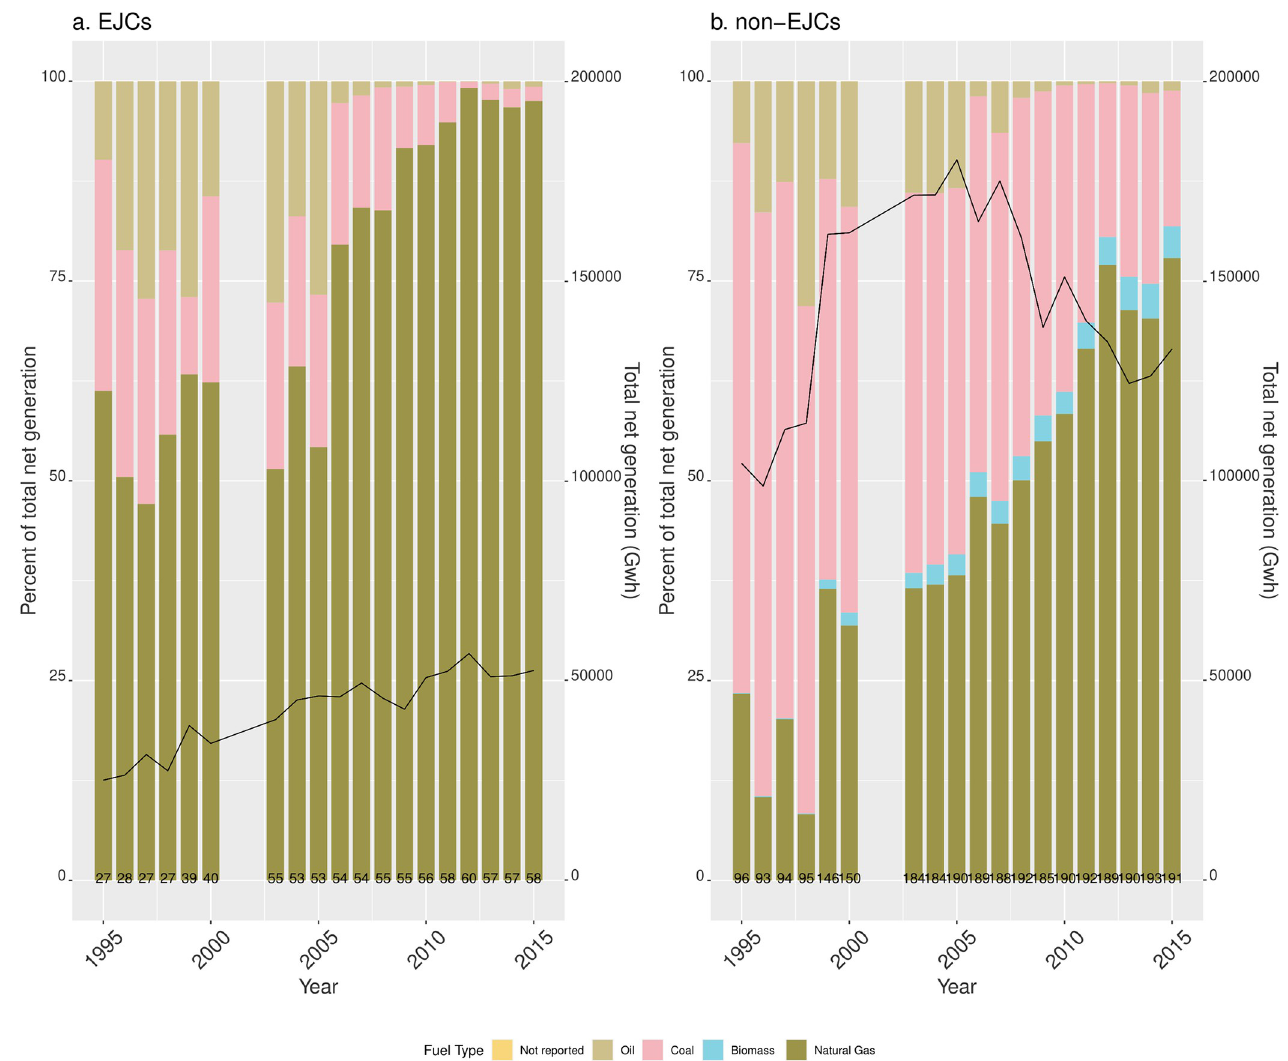
Fig 5. Total net generation by fuel type in EGUs in RGGI sited in (A) EJCs and (B) non-EJCs. Percent of total net generation by fuel type is indicated in left y- axis. Black lines indicate total generation and correspond to the right y-axis. EGUs that did not report fuel type also did not report generation and are thus omitted. The numbers at the bottom of the bars indicate the number of reporting units for each